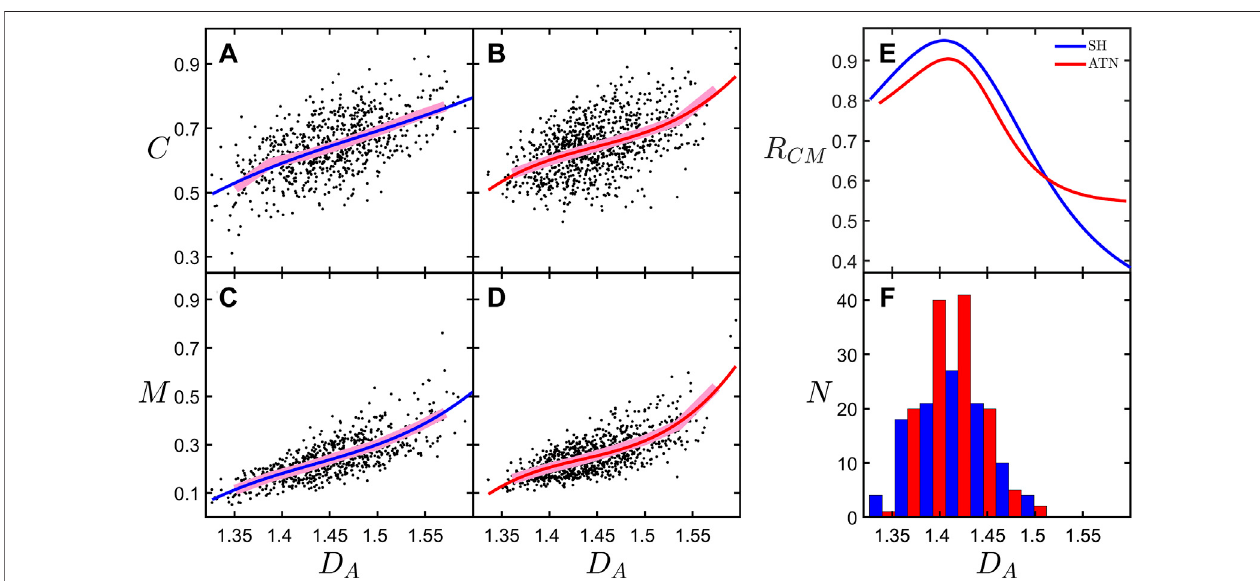
FIGURE 5 | Connectivity, C , plotted against arbor fractal dimension, D A , for the (A) SH and (B) ATN rodent categories. Mass cost, M , plotted against arbor fractal dimension, D A , for the (C) SH and (D) ATN rodent categories. (E) The ratio, R CM , of the derivates of the fi ts of C and M for each rodent category. (F) Histogram showing the number of neurons, N , across the range of D A values for the natural, undistorted basal arbors for the SH and ATN rodent categories. The legend in the upper-right corner of (E) applies to all ofthe fi gure panels. (A – D) , the underlying data corresponds toboth natural and distorted basalarbors; the broad, pink lines correspond with binned averages of the data; and the red and blue curves correspond to third degree polynomial fi ts to the data.